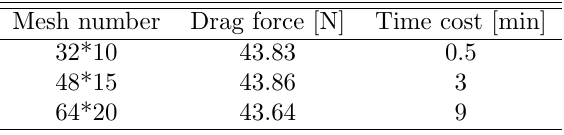
Table 2: Results from numerical models with different mesh configurations.